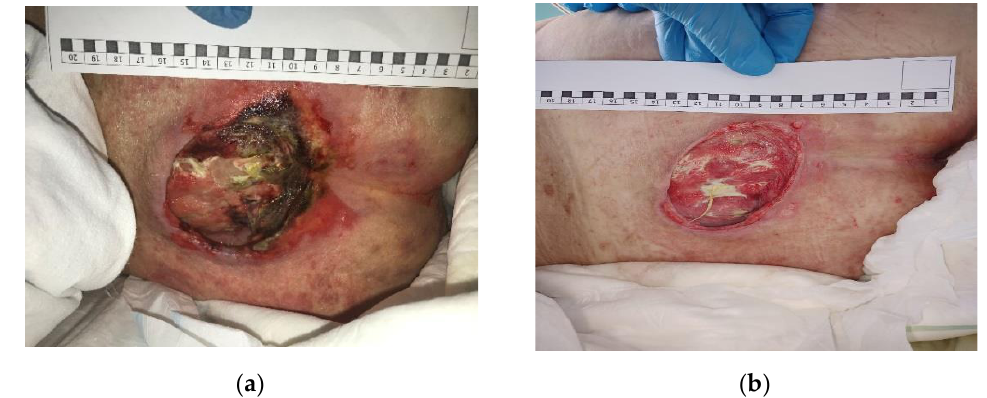
Figure 6. Dynamics of the pressure sore in the control group: ( a ) before treatment and ( b ) on the 30th day.